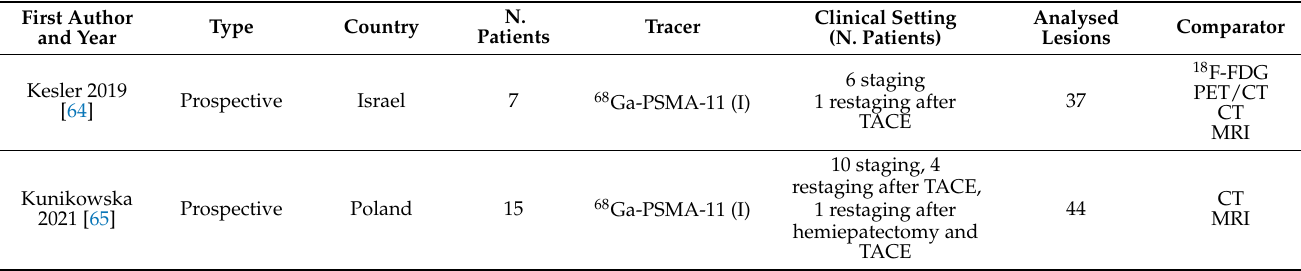
Table 6. Characteristics of the included studies which employed PSMA radioligands in hepatocellu- lar